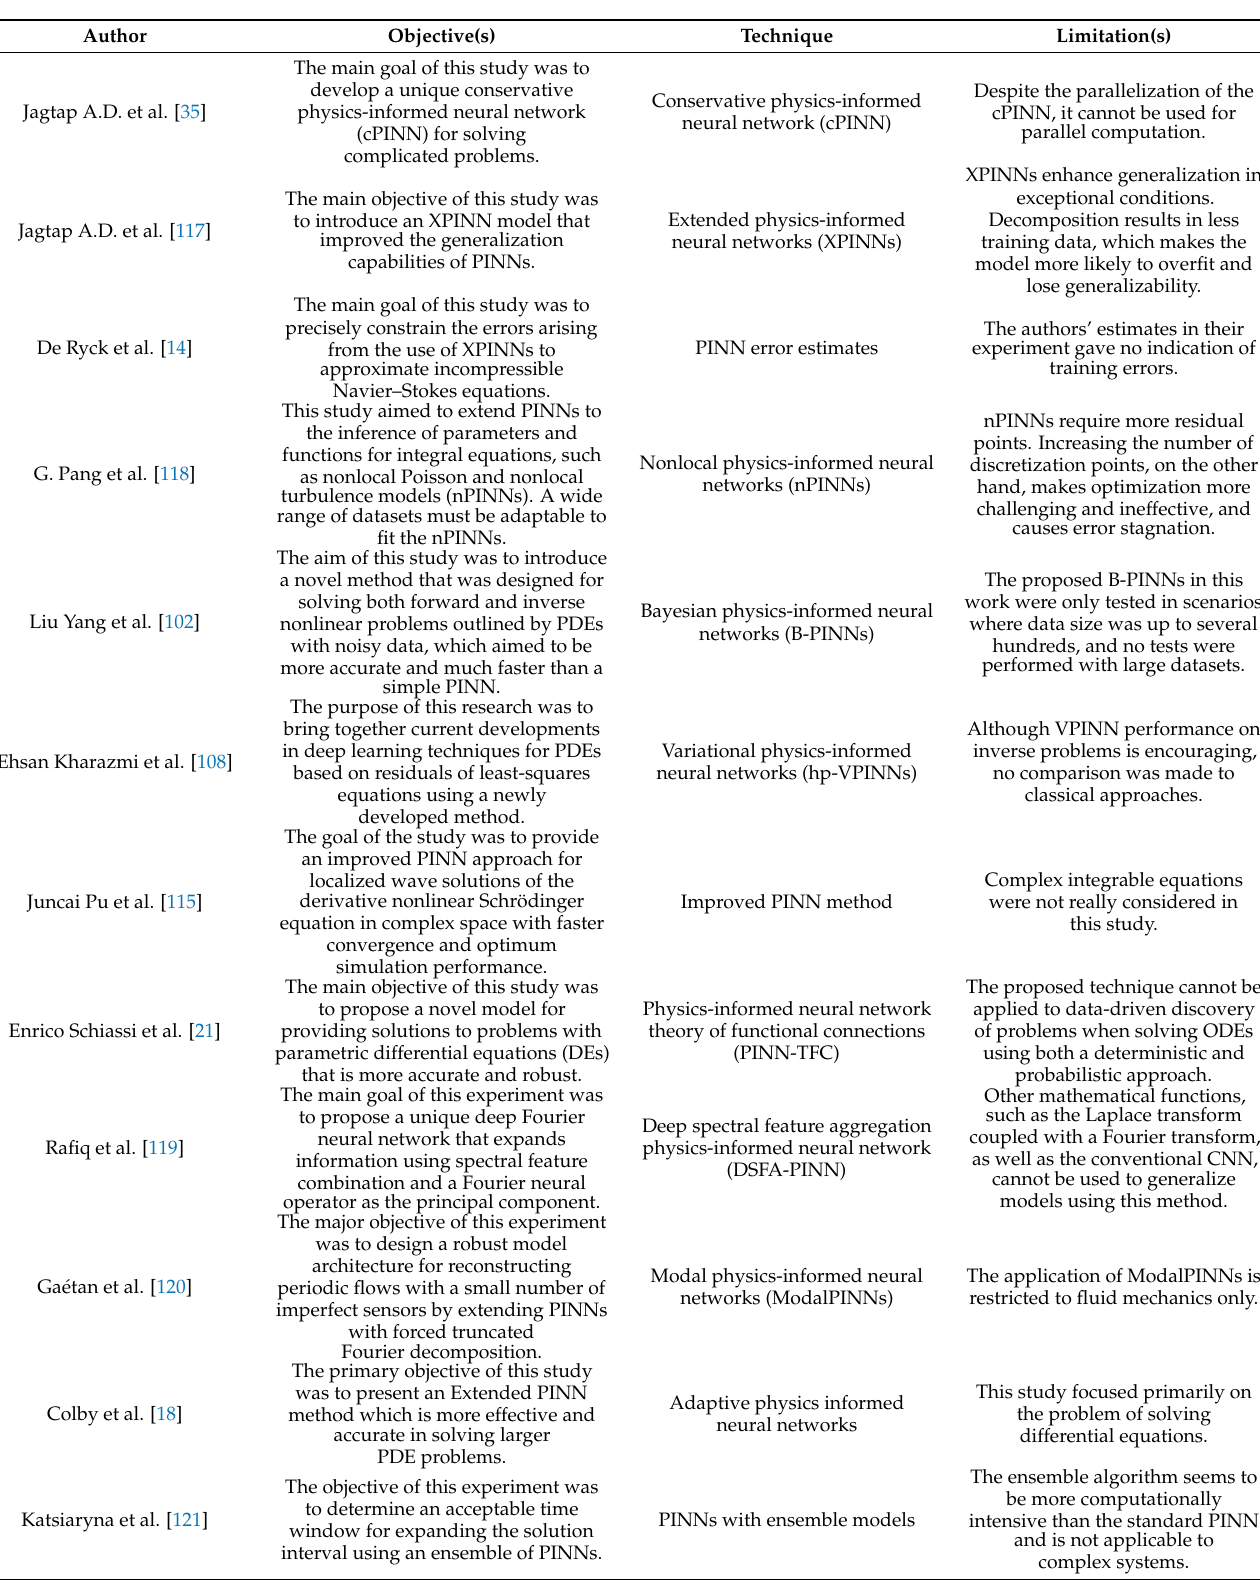
Table 3. Proposed Extended